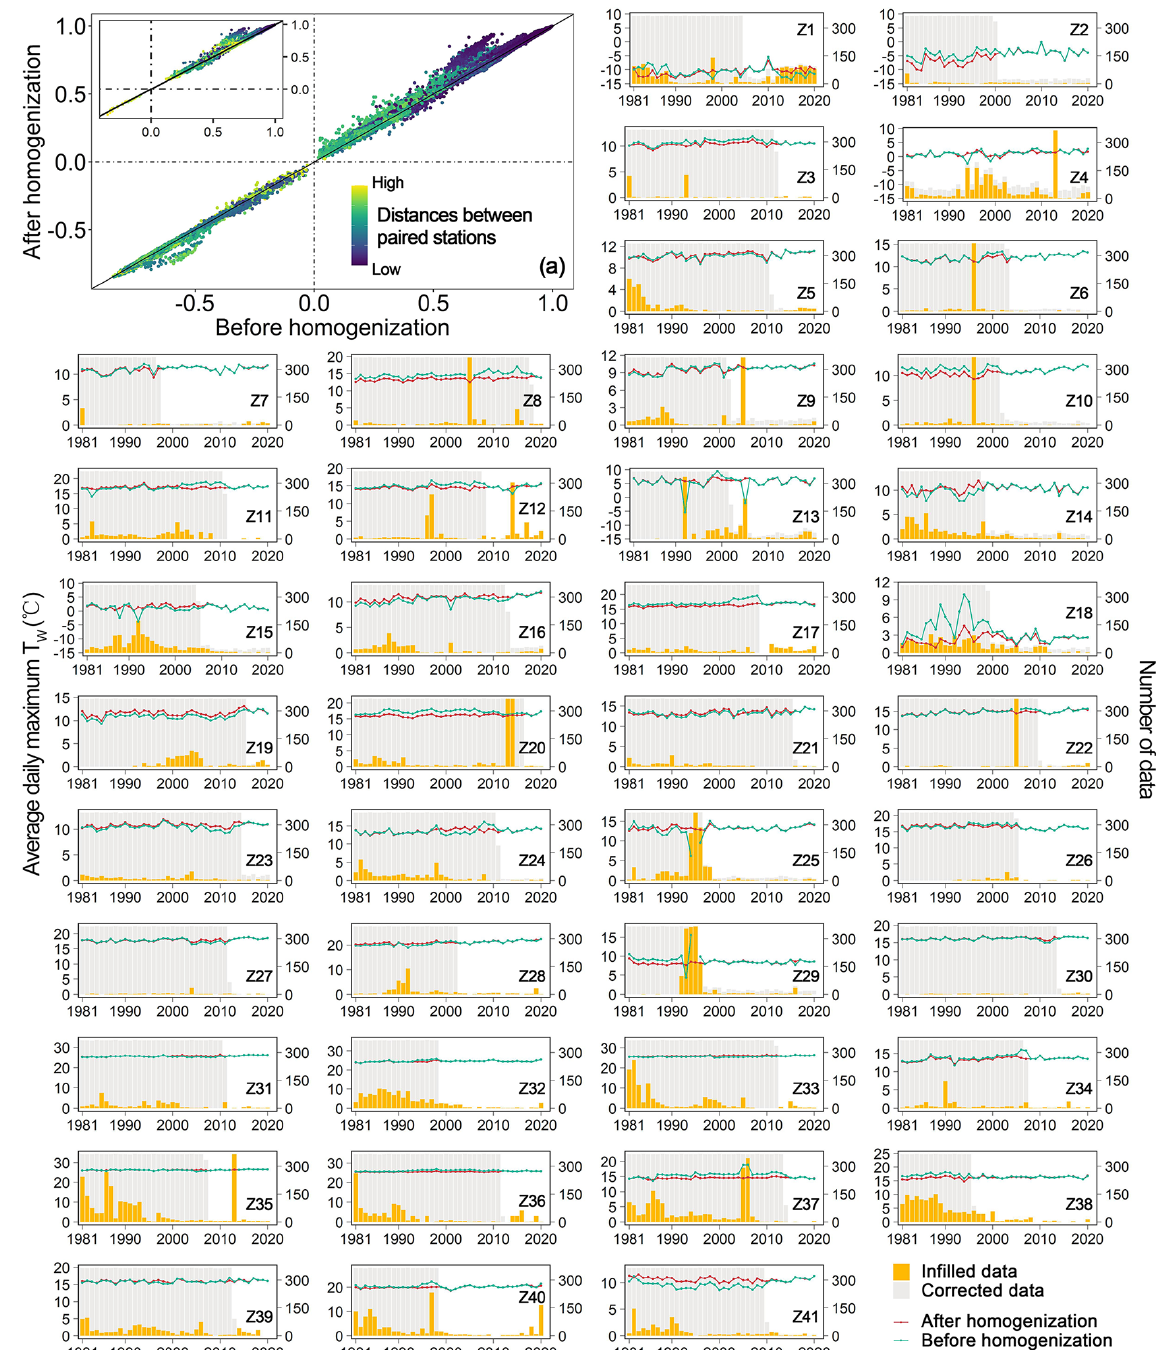
Figure 4. Correlation coefficients ( p < 0.05) between paired series before and after homogenization (a) , and annual average daily maximum T W ( ◦ C) and the number of infilled or corrected data for one typical station in each station zone (Z1–Z41). Sub-plot of the figure (a) showed the correlation coefficients between paired stations of which distances lower than the first quarter. When the coefficients were more than 0, the dots in the upper areas of black diagonal indicated the higher coefficients after homogenization. Detailed information of all typical stations was shown in Table